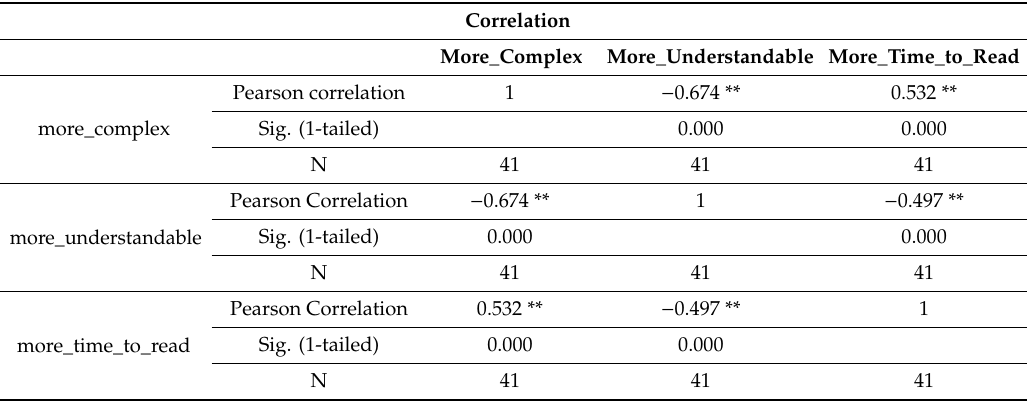
Table 6. Results from the correlation between the three main